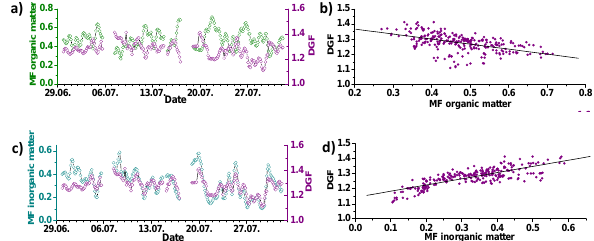
Fig. 3. Correlation between DGF at a RH of 90% and the mass Figure 3. Correlation between DGF at a RH of 90% and the mass fraction (MF) of organic 3 fraction (MF) of organic matter in summer (a) and the inorganic matter in summer (a) and the inorganic MF in summer (c) with the corresponding scatter plots 4 MF in summer (c) with the corresponding scatter plots (b, d) . The (b, d). The linear equation is y=-0.33x+1.44 with a correlation coefficient of -0.52 in (b) and 5 linear equation is y = − 0 . 33 x +1 . 44 with a correlation coefficient of y=0.41x+1.14 with a correlation coefficient of 0.79 in (d). 6 − 0.52 in (b) and y = 0 . 41 x + 1 . 14 with a correlation coefficient of 0.79 in (d) .